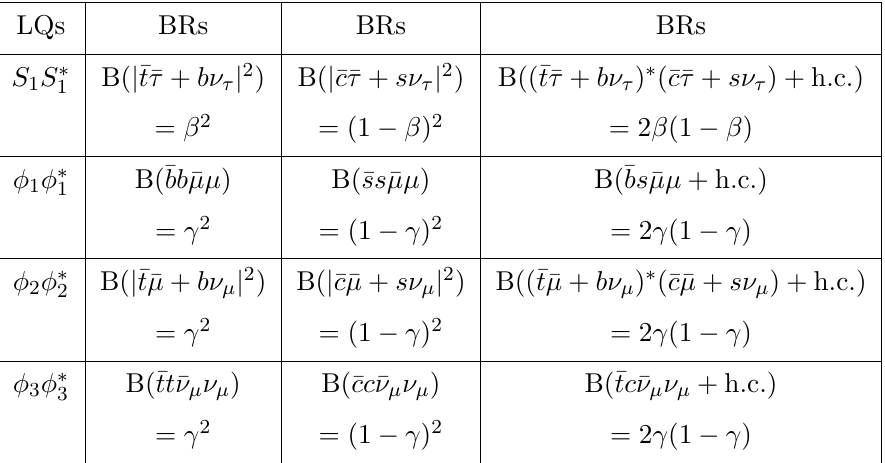
Table 2 . Branching ratios of products of DM annihilations into leptoquarks. Here, (cid:12) (cid:17) (cid:21) 2